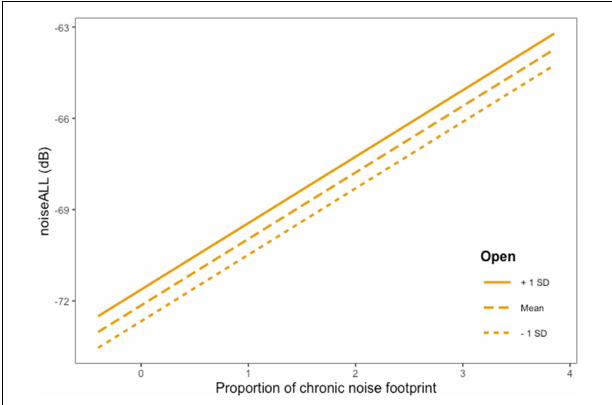
FIGURE 5 | Graphical representation of model predictions of the relationship between noiseALL and proportion of footprint though to create chronic noise as influenced by proportion of open habitat. Proportion of chronic footprint is centered to observe in detail changes in values higher than the